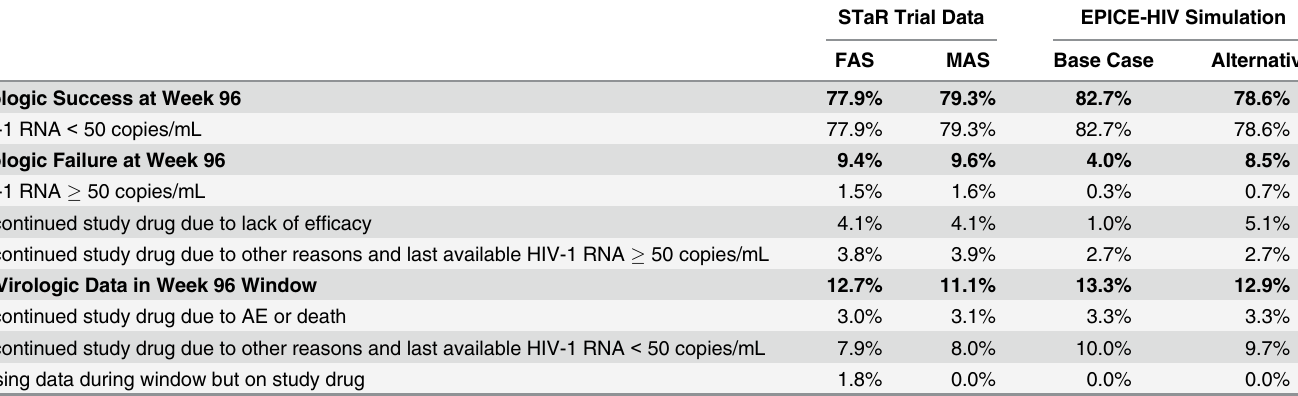
Table 8. Week 96 snapshot analysis for the RPV/FTC/TDF arm of the STaR study [33] and the simulated population in the EPICE-HIV model: detailed